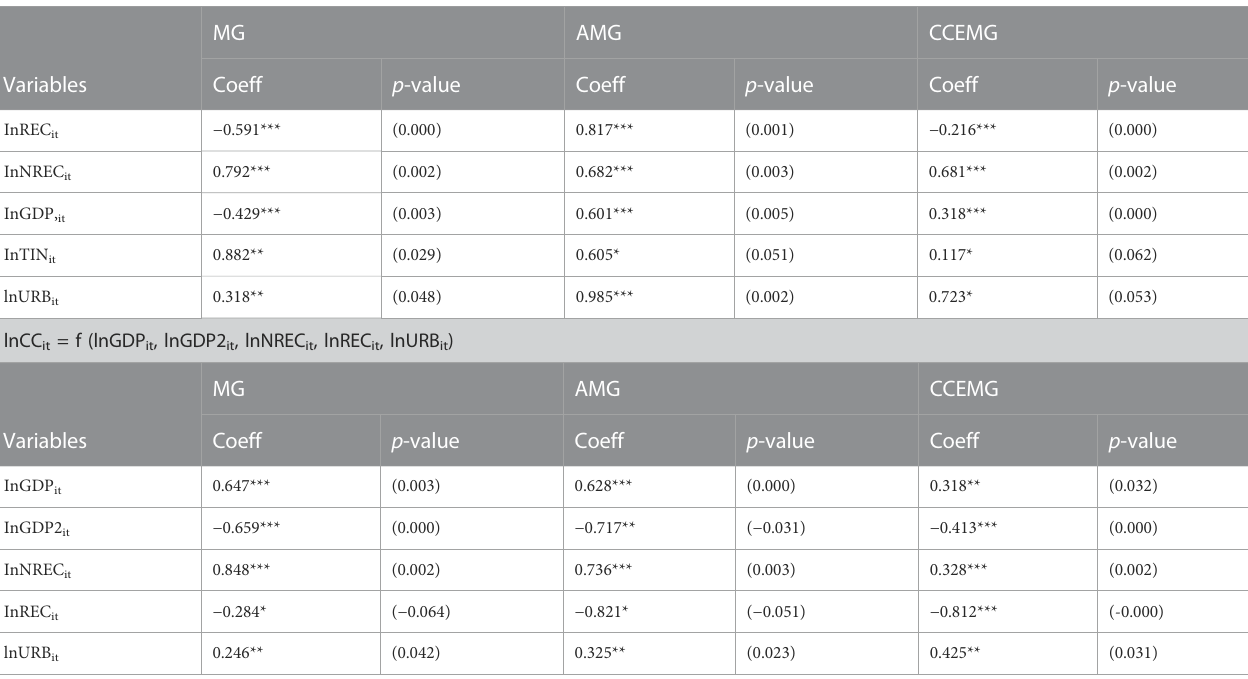
TABLE 6 Long-term coef fi cient estimation results using panel MG, AMG and CCEMG estimators. lnCC it= f (lnNREC it, lnREC it, lnGDP it, lnTIN it,